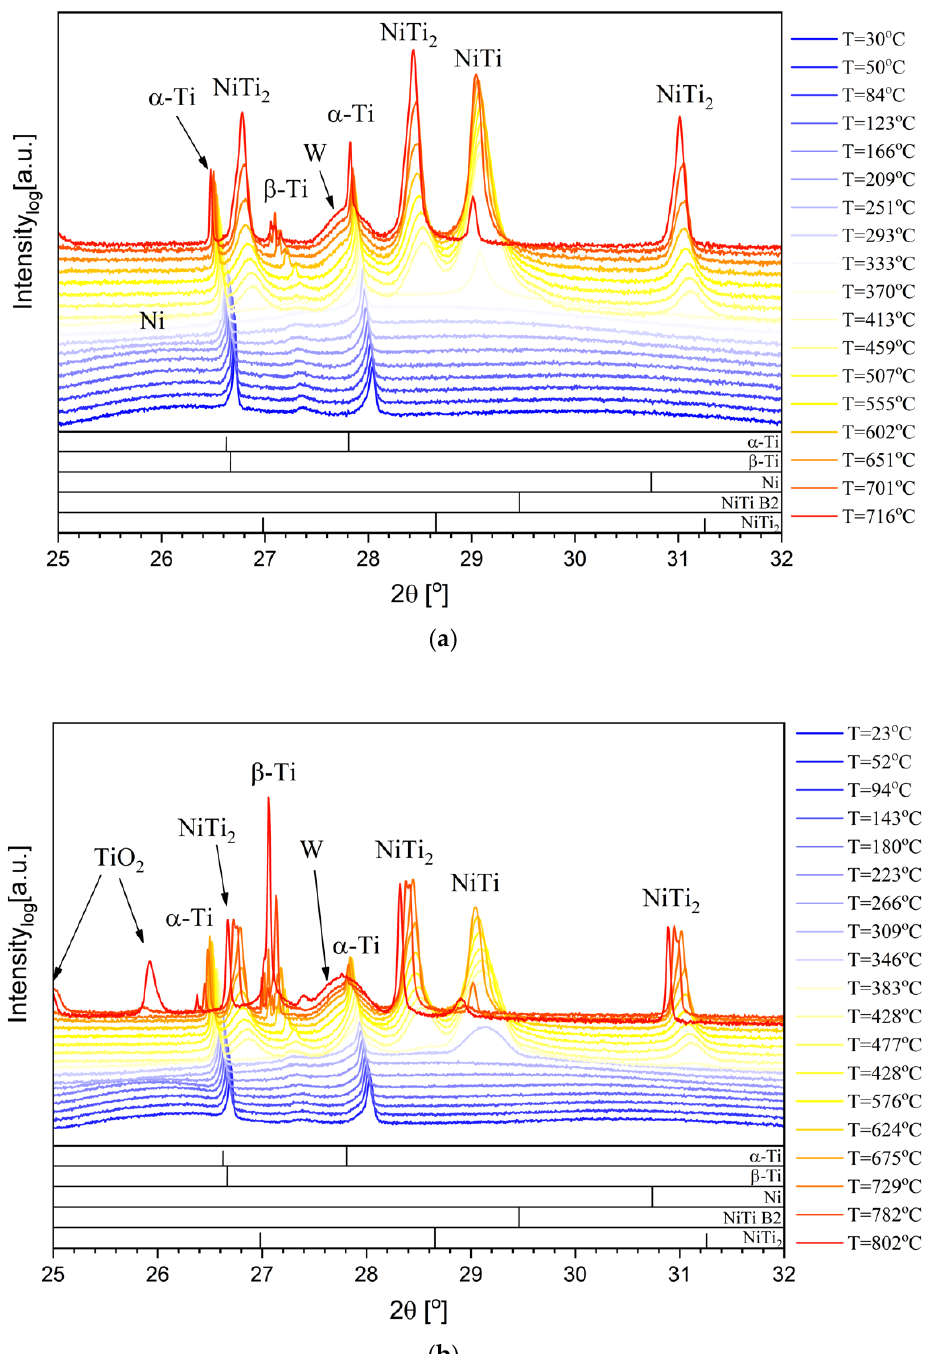
Figure 2. In situ synchrotron XRD phase evolution of multilayer thin films (W interlayer) with ( a ) 12 nm and ( b ) 25 nm